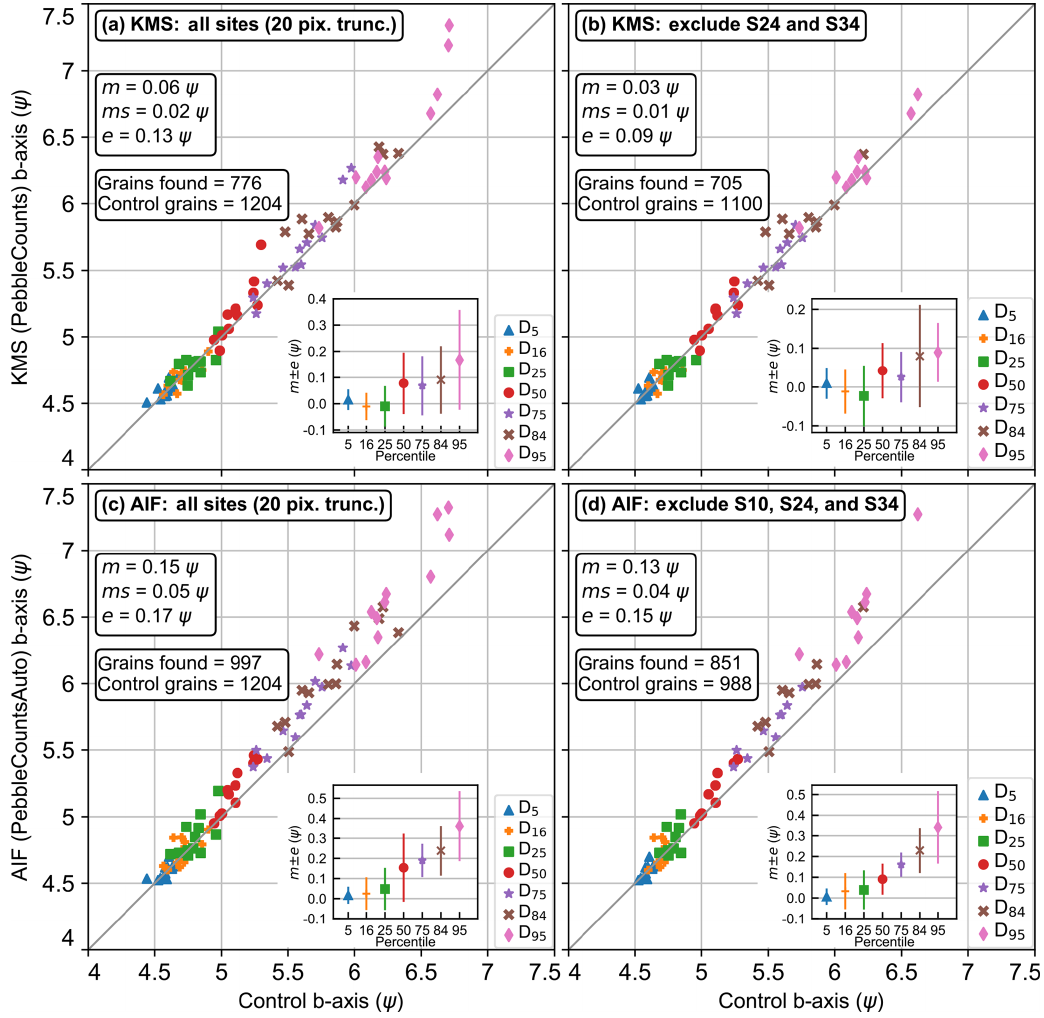
Figure 12. Comparing the key b -axis percentiles across all 12 field sites and between the KMS and AIF approaches with the 20-pixel truncation applied. (a) All 12 sites from KMS, (b) KMS improvement when excluding S24 and S34, (c) all 12 sites from AIF, and (d) AIF improvement when excluding S10, S24, and S34. For the main plot, each data point is a percentile value from a single site and the 1:1 relationship is the gray diagonal. The mean ( m ), mean squared (ms), and irreducible ( e ) errors are shown for each plot, taken as the average of all seven percentile errors across the 9–12 sites plotted. The m and e are separately plotted for each percentile in the inset plot. The number of grains in the control (“control grains”) and KMS or AIF results (“grains found”) is also indicated. The individual site curves where these data points originate are shown in Sect. S5 and Fig.